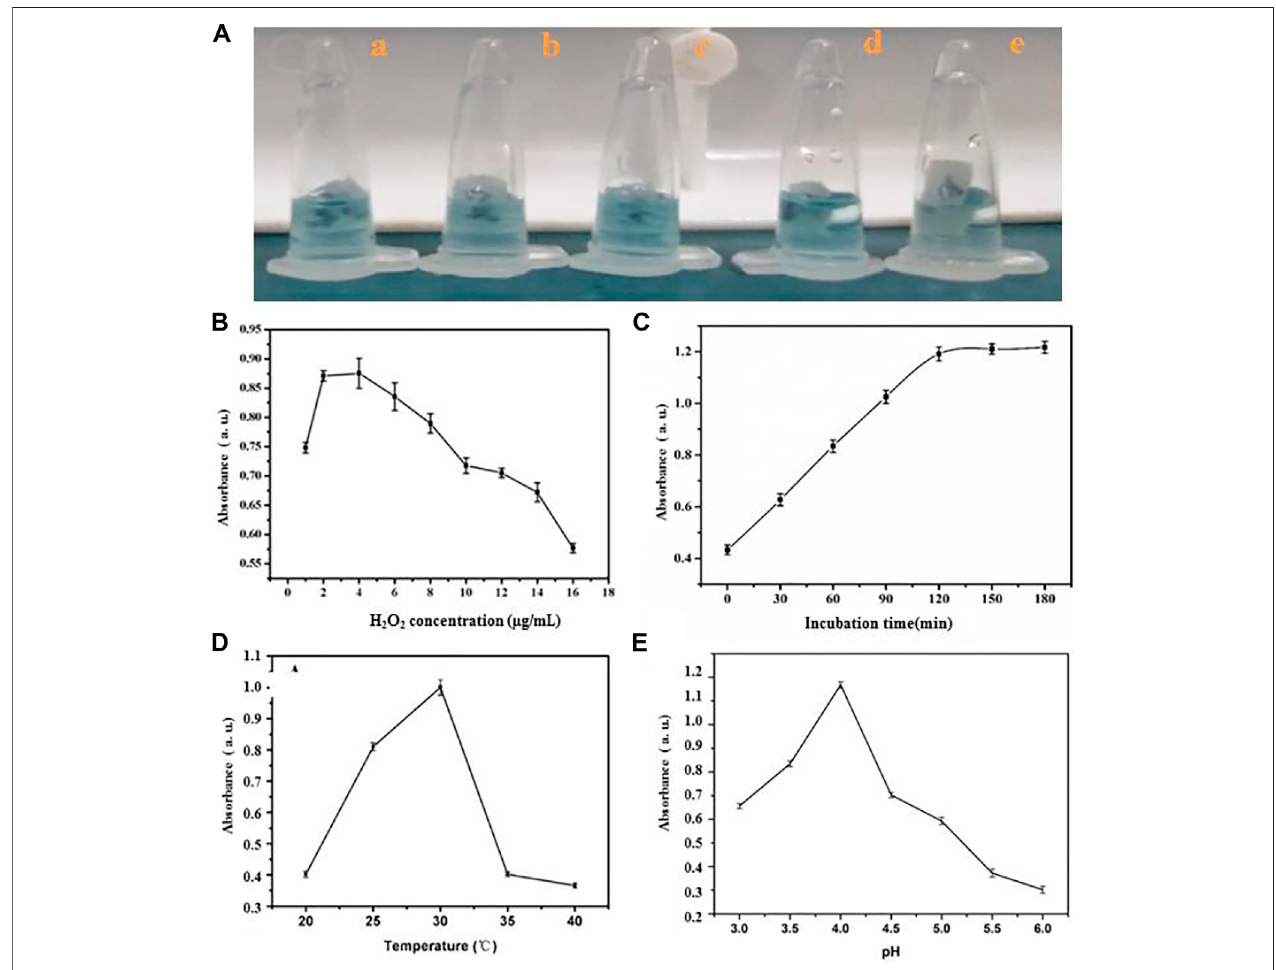
FIGURE3| Thein fl uenceof (A) amount ofHRP(a)4 μ g/ml (b)6 μ g/ml(c) 8 μ g/ml(d) 9 μ g/ml (e)10 μ g/ml, (B) quantity ofH 2 O 2 (C) incubating time (D) temperature and (E) pH value for sensing system.